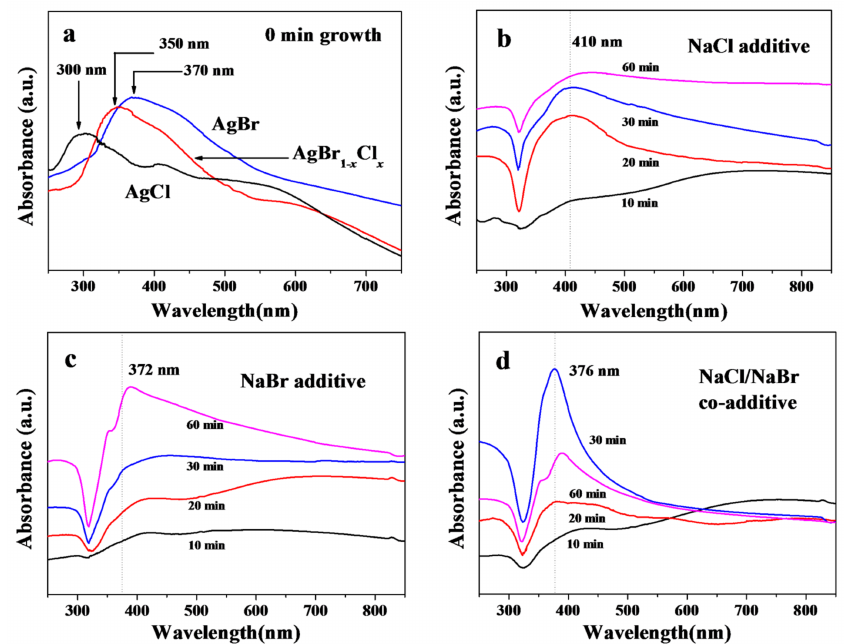
Figure 3. UV-vis absorbance spectra ( a ) of AgCl, AgBr and AgBr 1 − x Cl x crystals obtained at the beginning of synthesis and of the AgNW samples obtained with NaCl ( b ), NaBr ( c ) and NaCl/NaBr ( d ) additives. The vertical dotted lines in ( b – d ) indicate the positions of LSPR for the 30 min growth